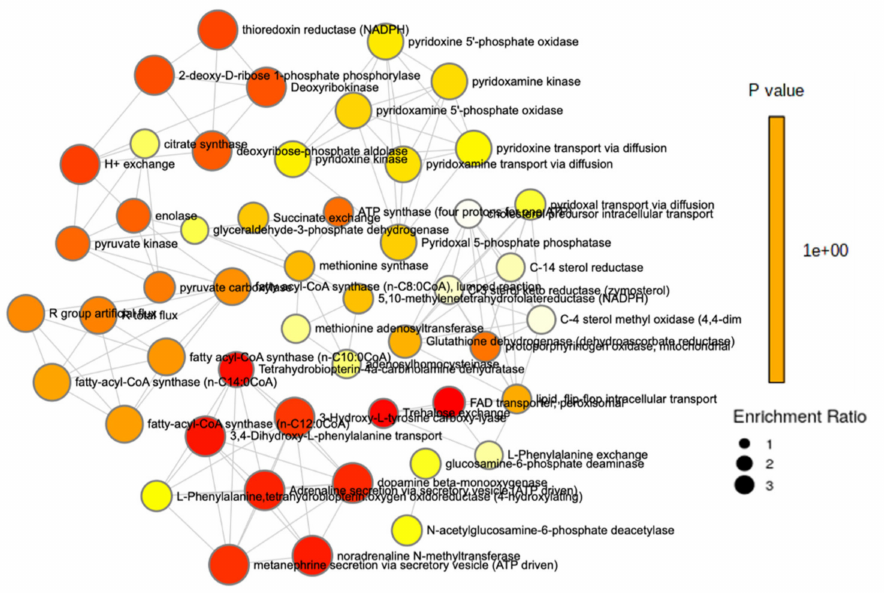
Figure 2. Enrichment analysis of sex and the metabolome. An independent Student’s t -test was used to compare metabolites of male and fe- male participants, with 24 metabolites being significantly different. Males had a higher concentration of proline, betaine, L-alloisoleucine, isoleucine, 2-methyl-2-oxovaleric acid, glutamic acid, citraconic acid, 4-methyl-2-oxopentatonic acid, 2/3-aminoisobutyric acid, hy- poxanthine, 2-hydroxyphenylacetic acid, leucic acid, picolinic acid, tyrosine, 3-phenyllactic acid, phenylpyruvic acid, and 2-aminoadipic acid. Meanwhile, females had a higher concentration of myristic acid, 2,3-dihydroxybenzoic acid, protocatechuic acid, creatine, 9-octadecyonic acid, and lauric acid (Table S8). A log 10 -scaled OPLS-DA model